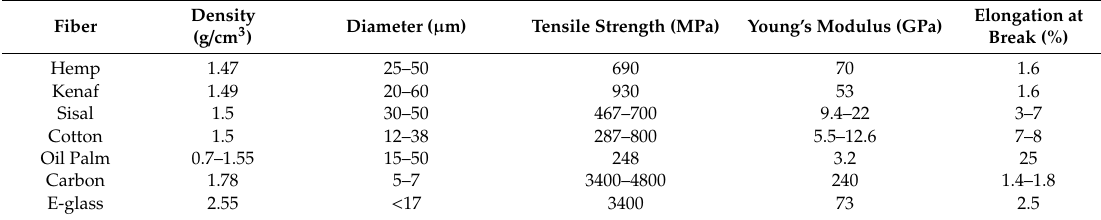
Table 1. The comparison of properties of natural cellulose, carbon, and E-glass fibers [3,18].